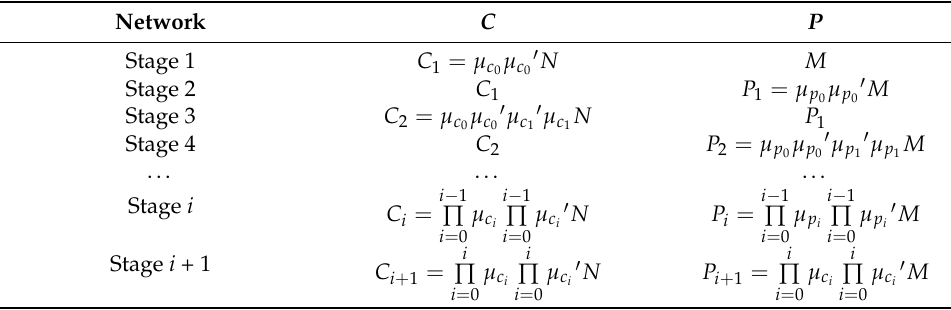
Table 2. Recursive failures between